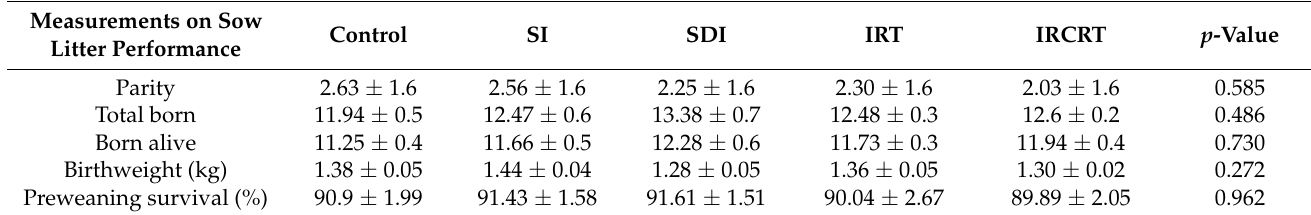
Table 5. Effects on sow performance of cloprostenol administered either as a single vulval injection at 0700 h, vulval injection at both 0700 and 1300 h, insertion of a rapid release (IR) NVDDS at 0700 and 1300 h, or both IR and controlled release (CR6) tablets at 0700 h or untreated controls. The statistical significance of mean values is presented as a p -value, where p ≤ 0.05 indicates a significant result at the 95% level of confidence.